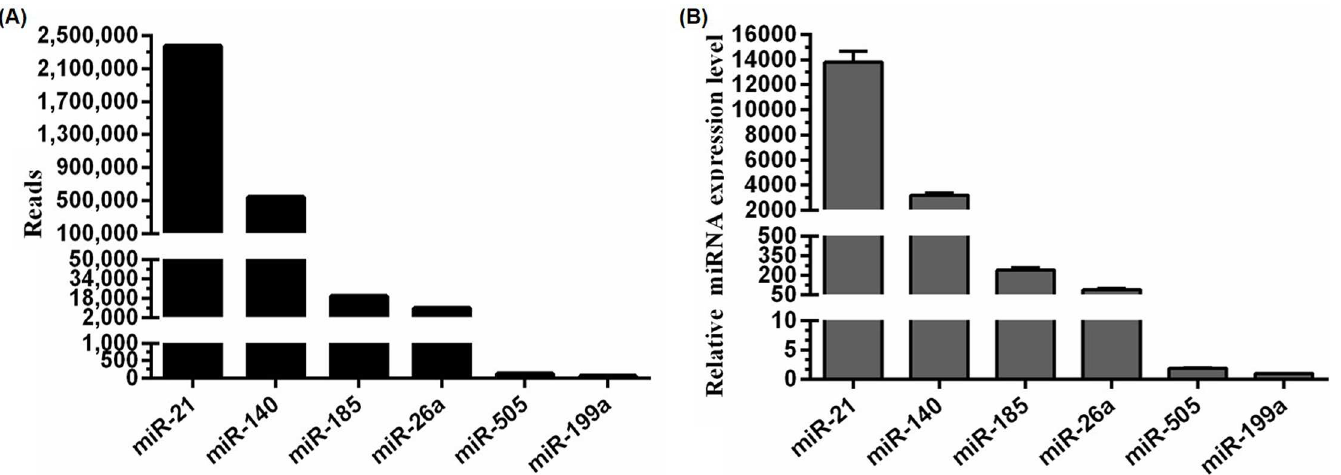
Fig 2. Copy numbers of candidate miRNAs determined by Illumina deep sequencing and validation of their expression levels using stem-loop qRT-PCR. A: Reads of the six selected miRNAs obtained from PRRSV-infected MARC-145 cells are shown along the Y-axis ( black bars ). B: MARC-145 cells were infected with vAPRRS at an MOI of one, and miRNA expression was determined at 24 hpi using stem-loop qRT-PCR. Relative expression levels were normalized against snRNA U6. Data are shown as the mean ± standard deviation (SD) of three independent experiments.